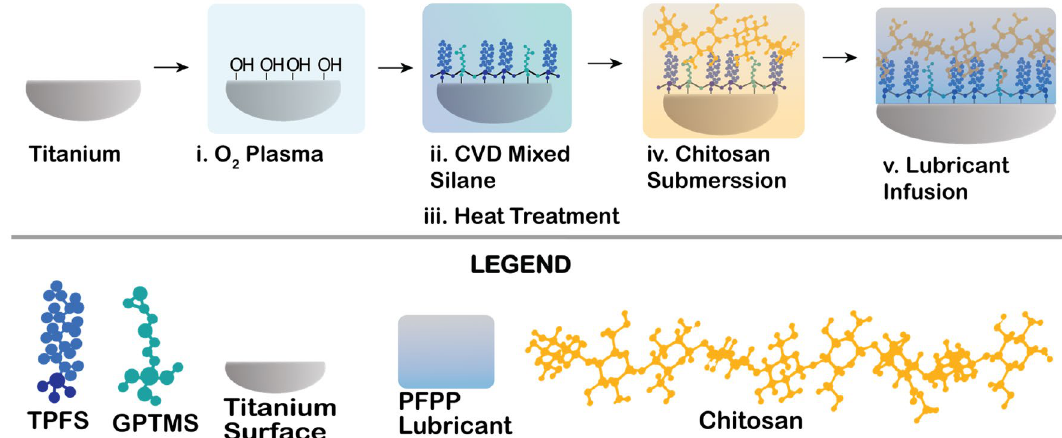
Figure 1. Fabrication schematic. Schematic representation of the fabrication process for the chitosan conjugated liquid-infused coating on